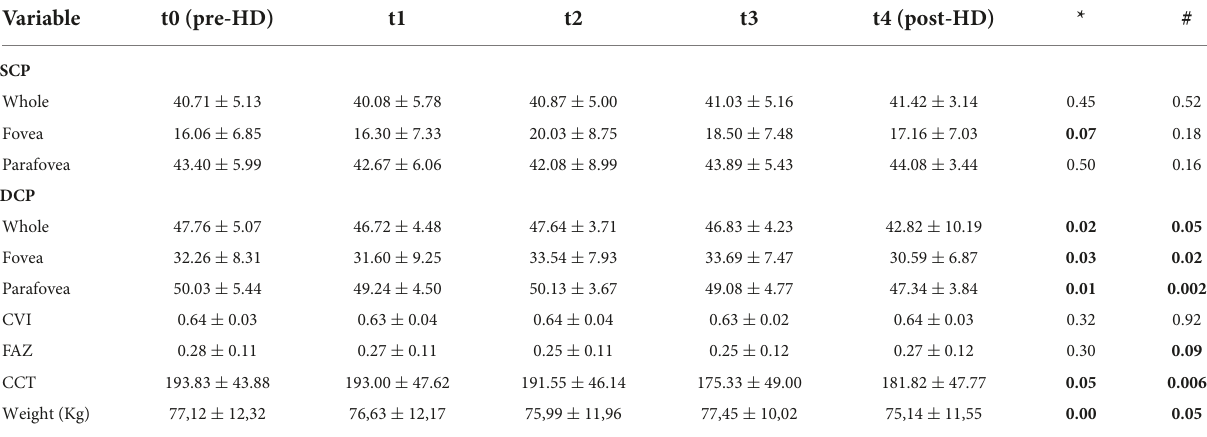
TABLE 2 Dialysis changes in OCT-A metrics in the whole